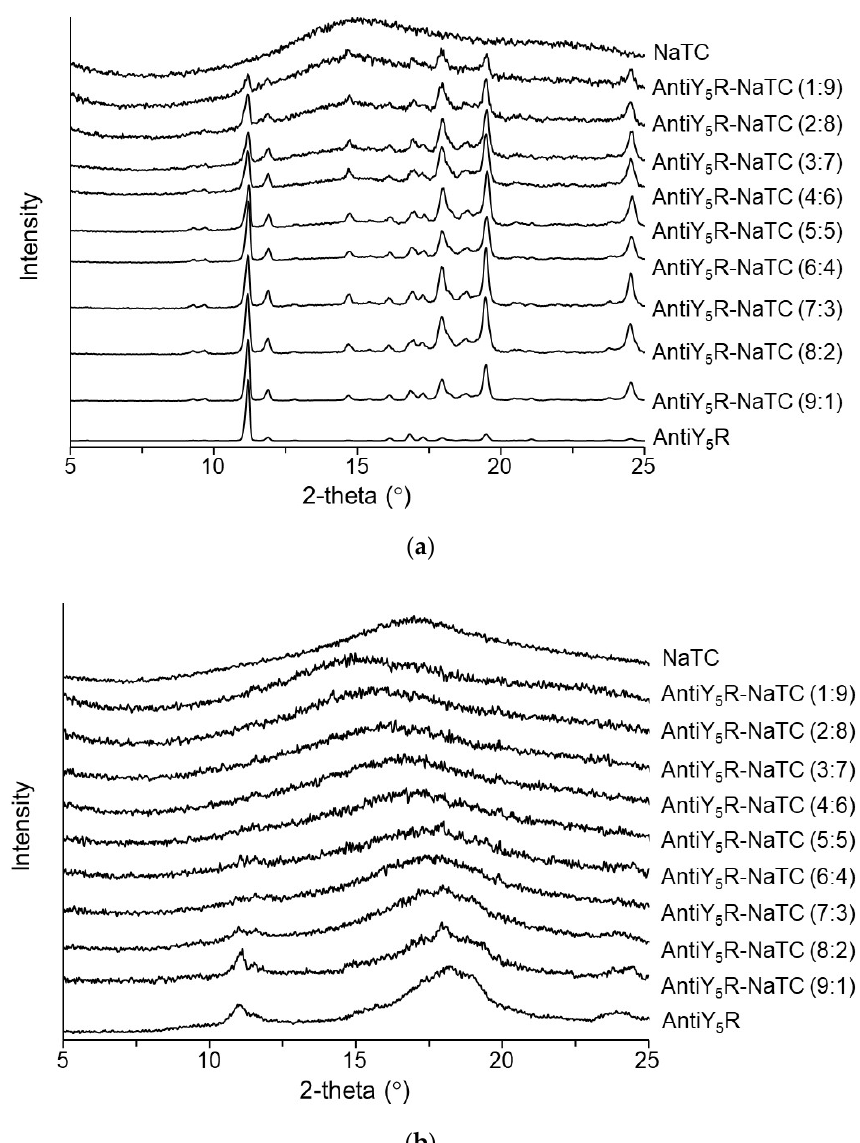
Figure 6. XRPD patterns of AntiY 5 R, NaTC and mixtures of AntiY 5 R and NaTC at different molar ratios. Typical patterns of XRPD for ( a ) before ball milling and ( b ) after 180 min ball milling.